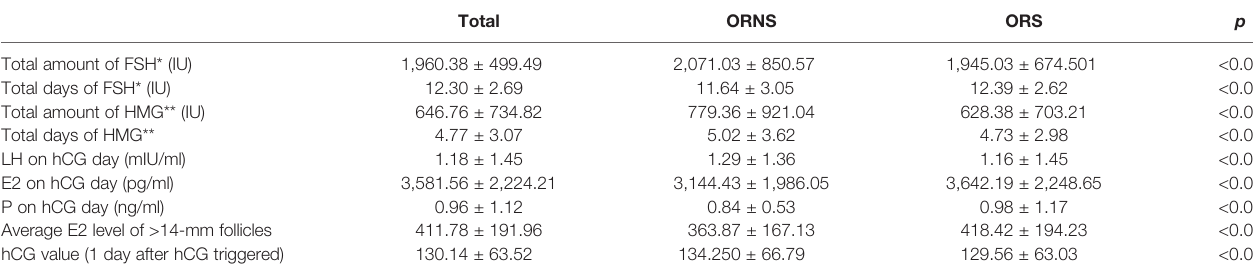
TABLE 3 | Gonadotropin dosage and duration comparisons between the ORNS group and the ORS